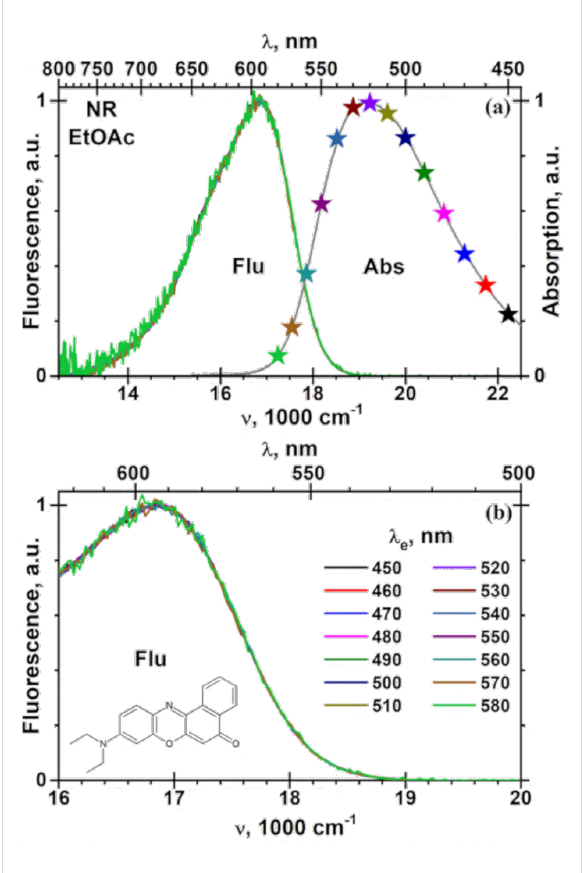
Figure 6: Absorption (a) and fluorescence (a, b) spectra of NR in ethyl acetate (EtOAc) at different excitation wavelength ( λ e ) at 25 °C. The λ e values are indicated with the stars on the absorption spectrum in panel (a).